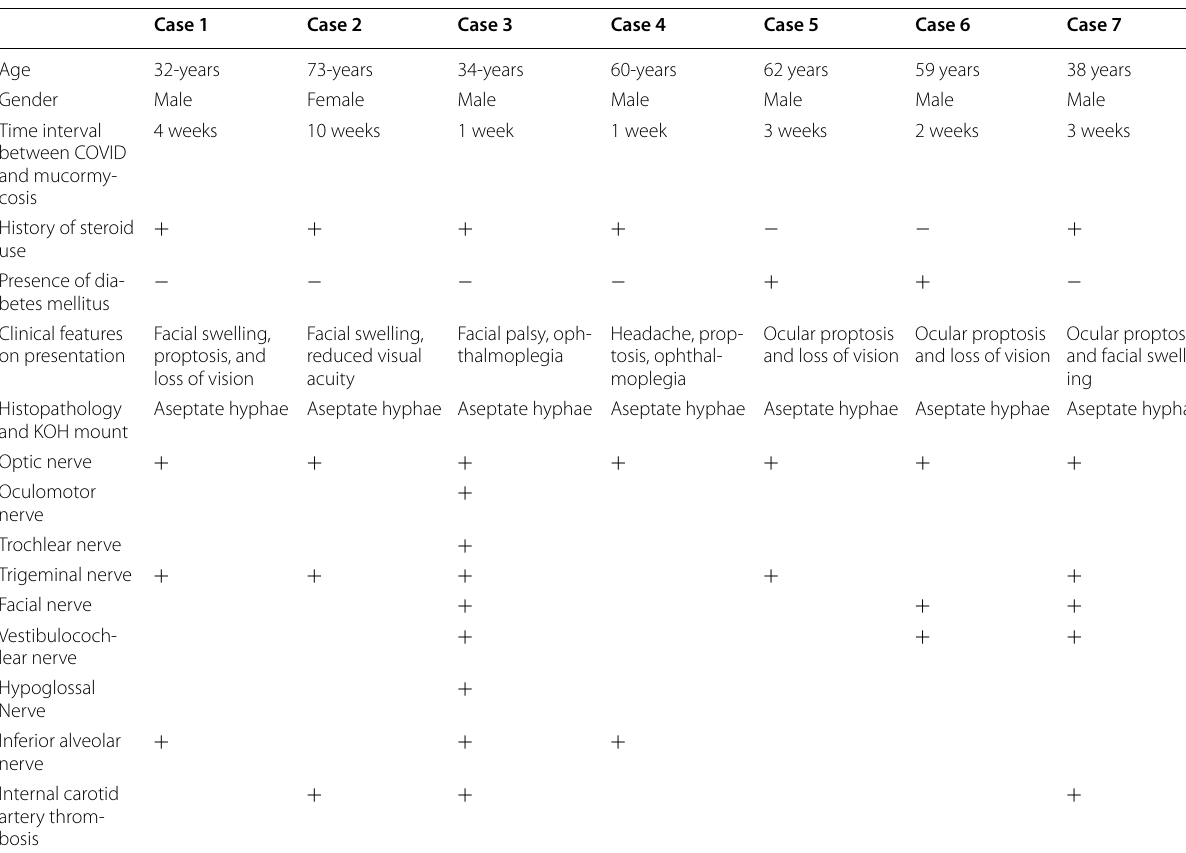
Table 1 Master chart for the